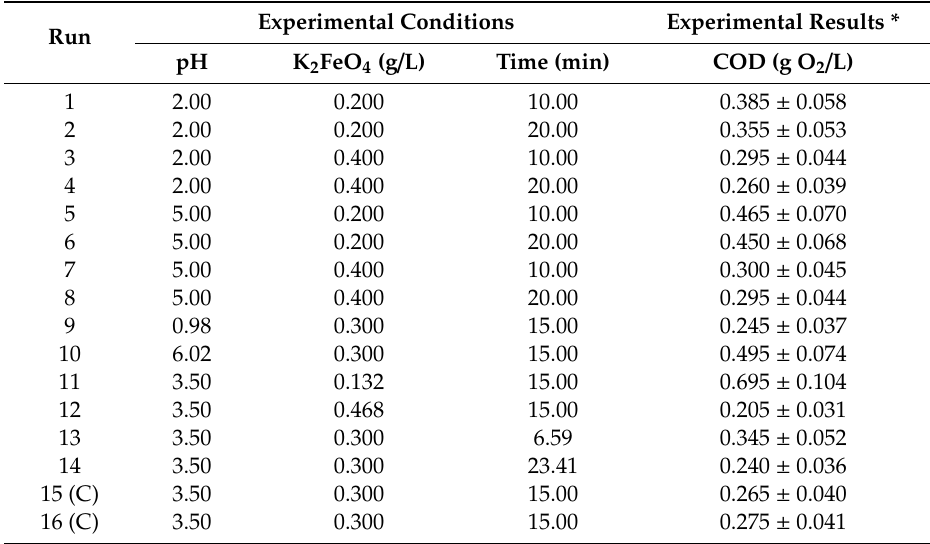
Table 1. Empirical conditions for the CCD / RSM and outcome (COD) for landfill leachate (pH